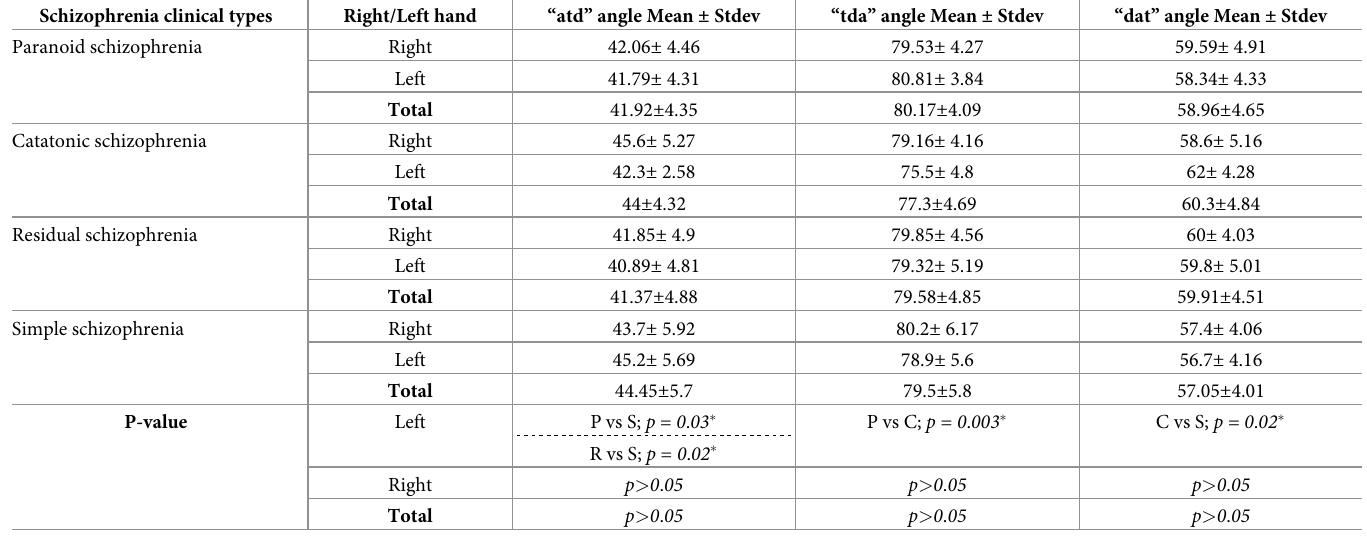
Table 10. Mean values of angles of atd, tda and dat in schizophrenic clinical